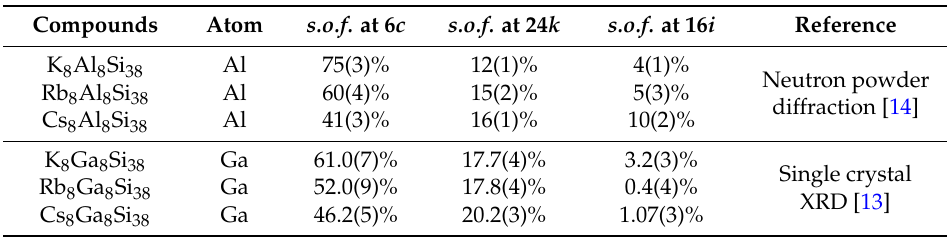
Table 2. Comparison of Al and Ga’s site occupancy fraction ( s.o.f. ) at the Si framework sites, 6 c , 24 k , 16 i of A 8 Tr 8 Si 38 (A = K, Rb, Cs; Tr = Al, Ga) compounds.